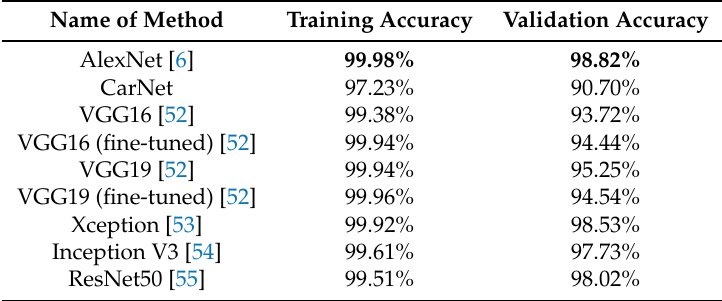
Table 9. Results related to PKLot [4] dataset. Comparison of training and validation accuracies for CarNet with well-known